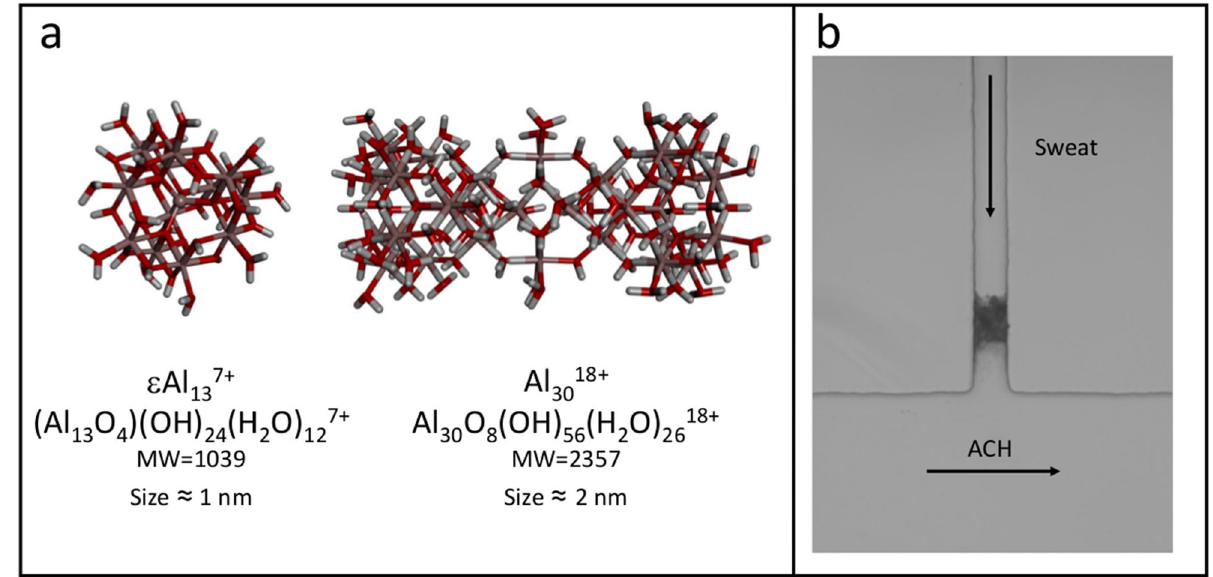
Figure 1. ( a ) Molecular modelling representation of εAl 13 and Al 30 clusters with corresponding nominal charge, molecular weight and size. These polycations are representative of active compounds present in the ACH solution. ( b ) Photograph of the microfluidic chip showing the two orthogonal channels mimicking a sweat pore and the skin surface. At the beginning of the experiment, the sweat channel (55 µm high × 50 µm wide) was flowed at 0.6 nL s −1 with natural human sweat collected from human volunteers. The ACH channel (55 µm high × 400 µm wide) was flowed at 60 nL s −1 ACH 15% (w/w) from left to right. The image shows the visual aspect of the plug after 30 min of pressure-controlled